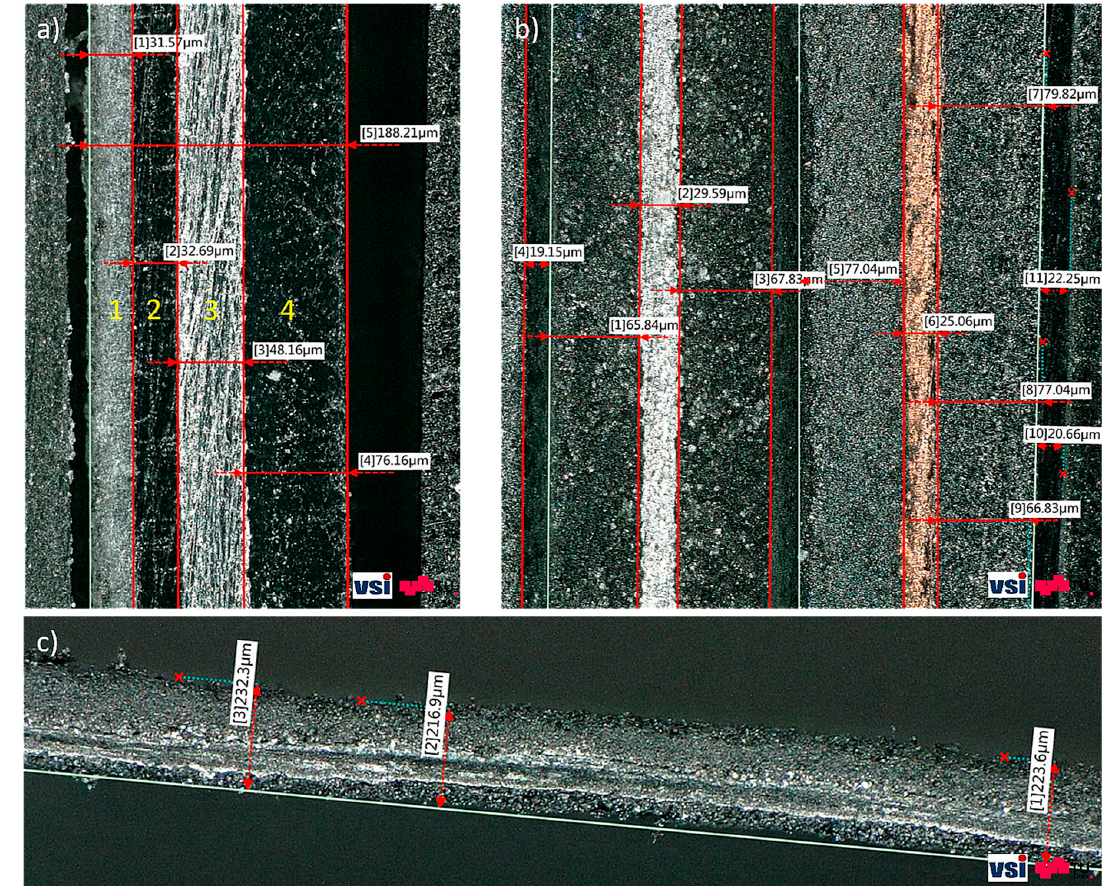
Figure 13. Cross-sectional imaging results generated by high-resolution light microscopy. ( a ) Pouch identified as a four-layer structure (carbon oxides marked with 1, 2, and 4 and aluminium marked with 3); ( b ) thickness measurements of the anode, the cathode, and the separator comparable to those determined with the SEM; ( c ) cross-sectional image of an unprocessed anode layer.